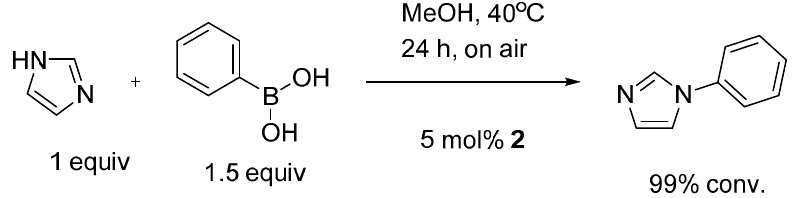
Scheme 2. Model reaction for the investigation of catalytic properties of polymer 2 .